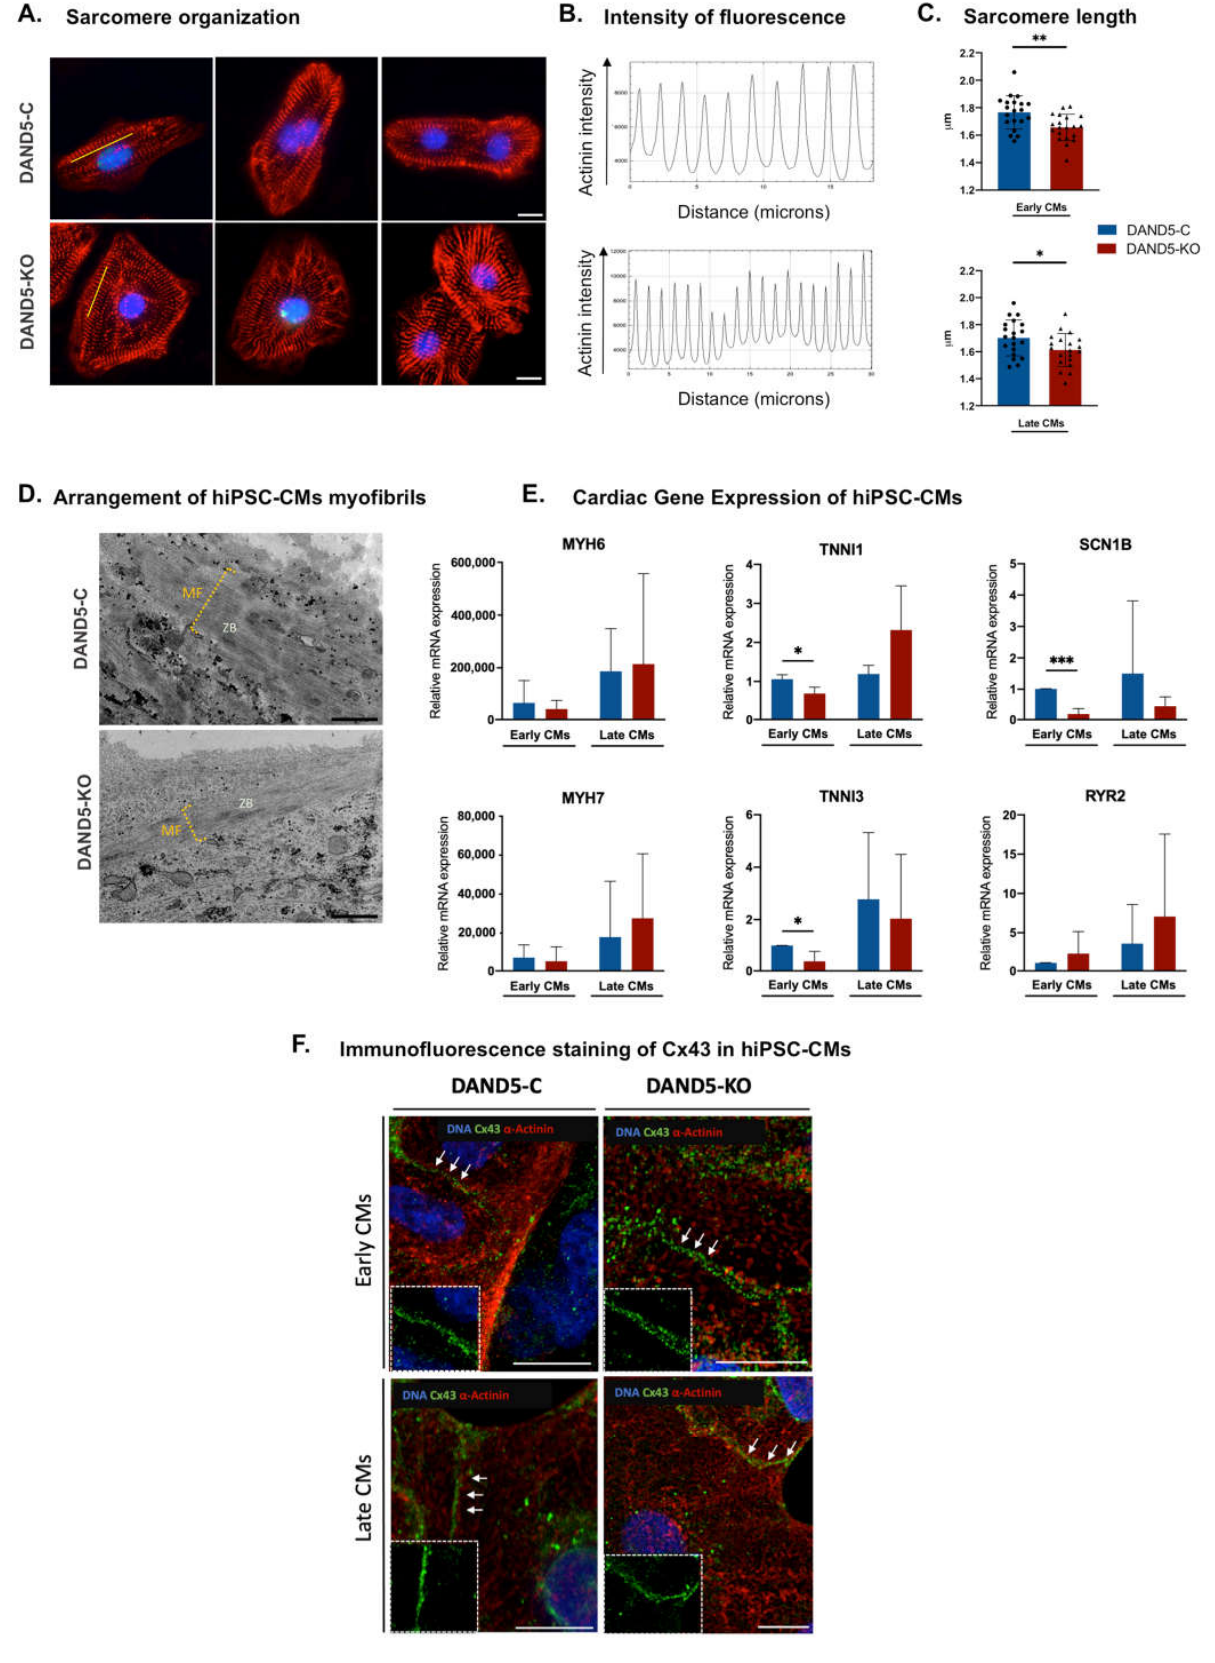
Figure 3. Structural and molecular analyses of DAND5 hiPSC-CM. ( A ) Representative immunofluo- rescence images of hiPSC-CM from DAND5-C and DAND5-KO cell lines at day 15 for